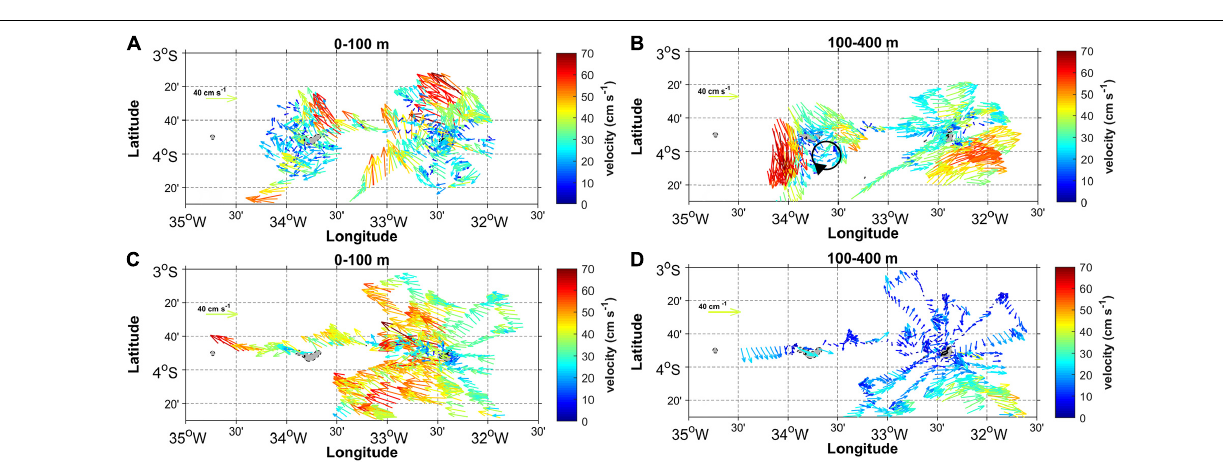
FIGURE 9 | Mean current velocity obtained from ABRACOS cruises at 0–100 m during spring 2015 (A) and fall 2017 (C) , and at 100–400 during spring 2015 (B) and fall 2017 (D) . Black circle in Figure 8B indicates the cyclonic mesoscale